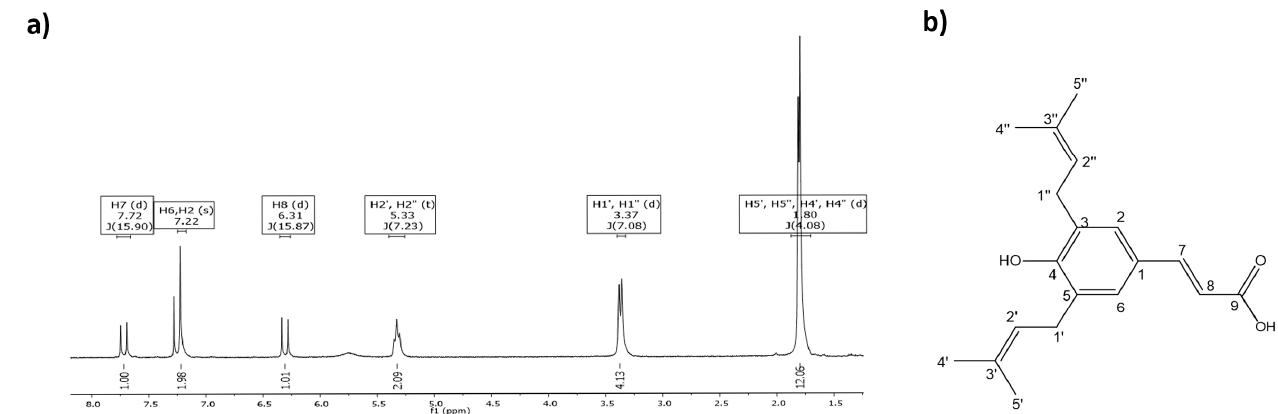
Figure 1. ArtC isolation. ( a ) 1 H NMR spectrum of ArtC (CD3OD, 300 MHz); ( b ) chemical structure of ArtC.